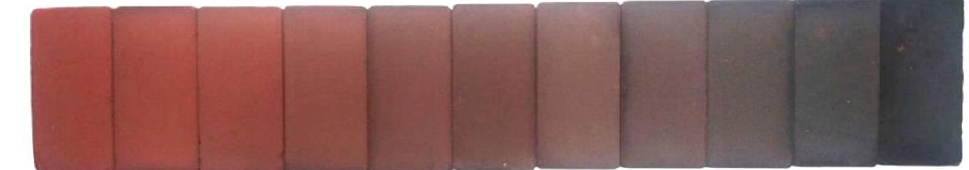
Figure 2. Image of the different families of samples formed with different percentages of brick dust and biomass bottom ash. and biomass bottom ash.